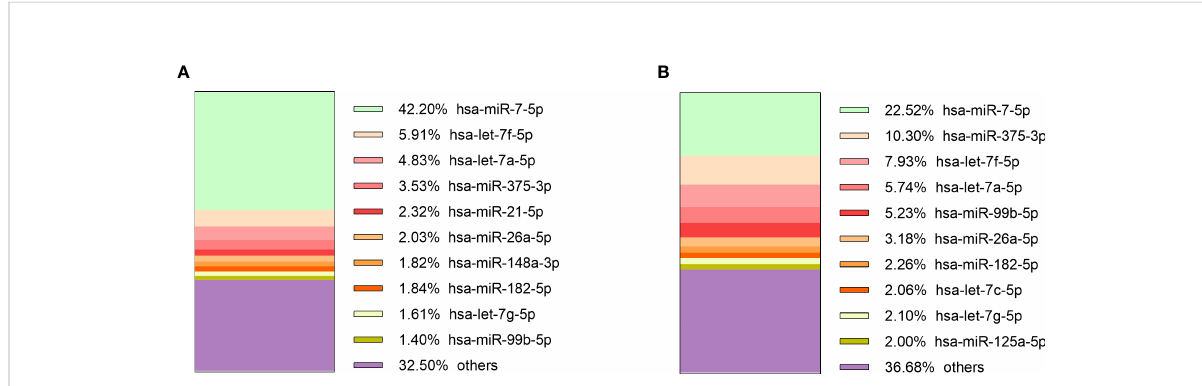
FIGURE 4 10 most expressed miRNAs in: (A) GH secreting PitNET tissues, (B) NF PitNET tissues.